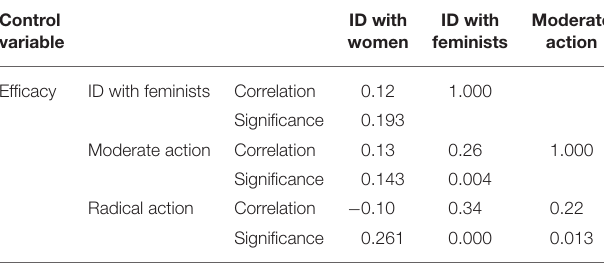
TABLE 3 | Correlation table for Study